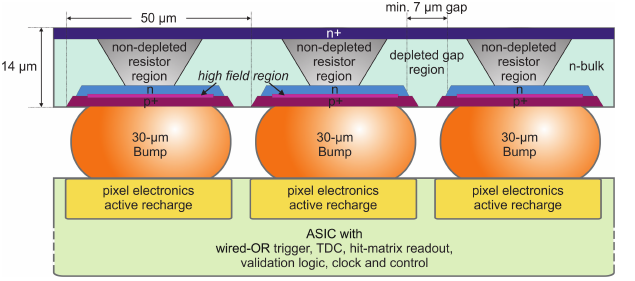
Figure 5. 3D PDC used as a charged particle detector. (Illustration courtesy of Inge Diehl,